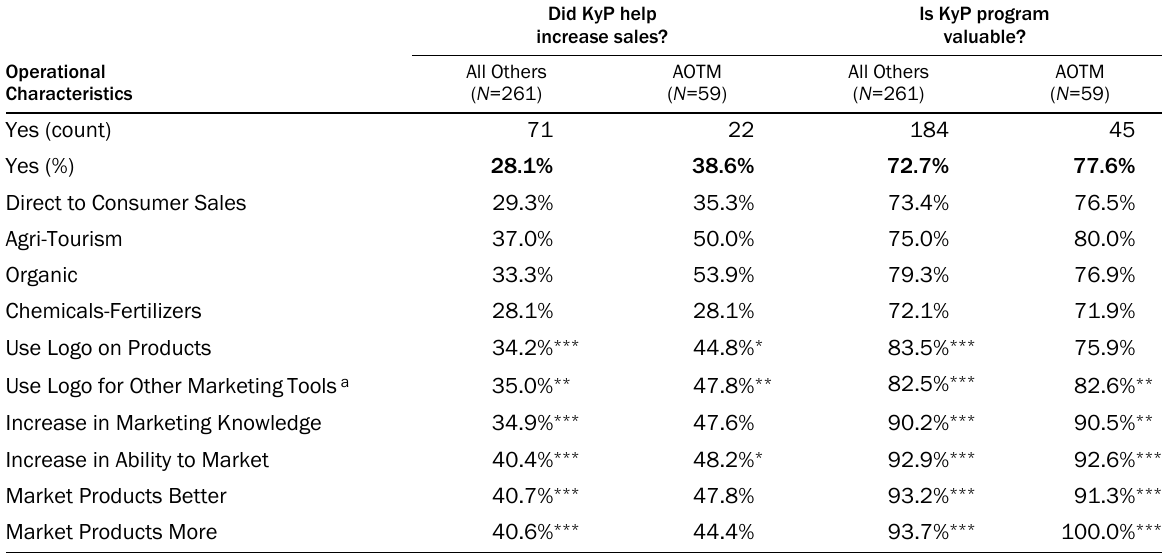
Table 4. Impact of Kentucky Proud ™ on Farmers, 2011 ( N =320)